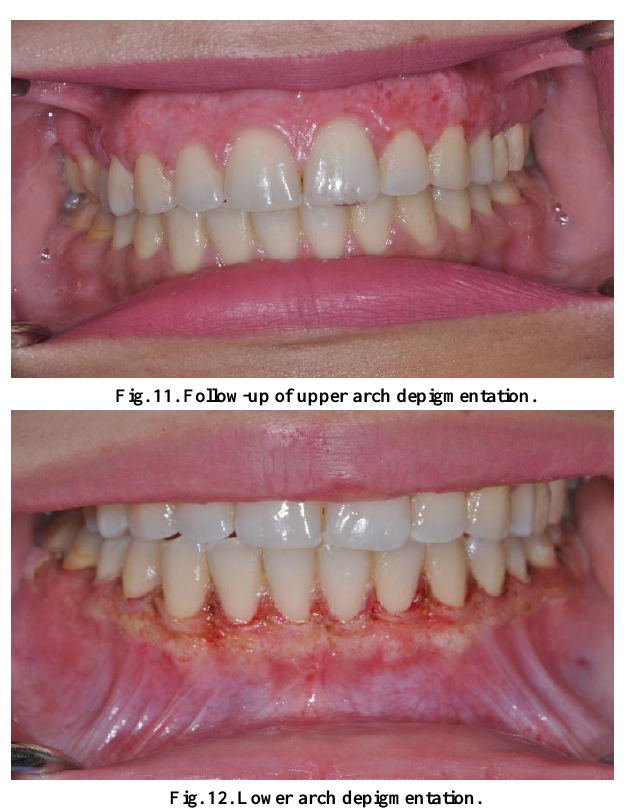
Fig. 12. Lower arch depigmentation.